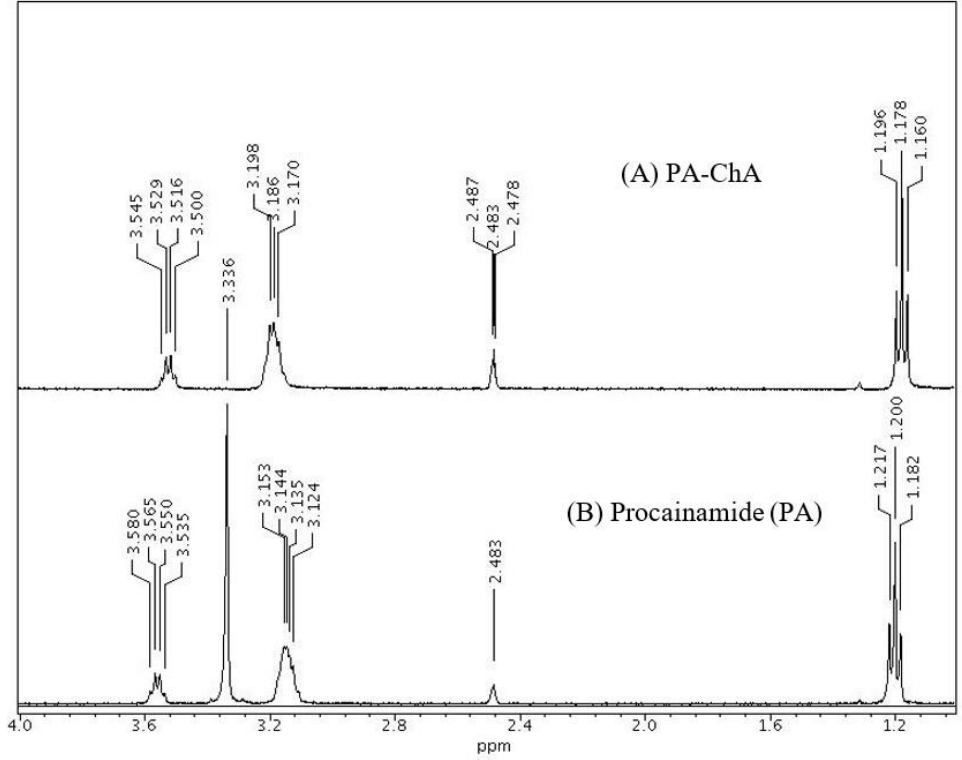
Figure 8. Comparison of proton-NMR ( 1 H-NMR) spectra of PA and PA-ChA complex: ( A ) aliphatic region of PA-ChA complex; ( B ) aliphatic region of PA.